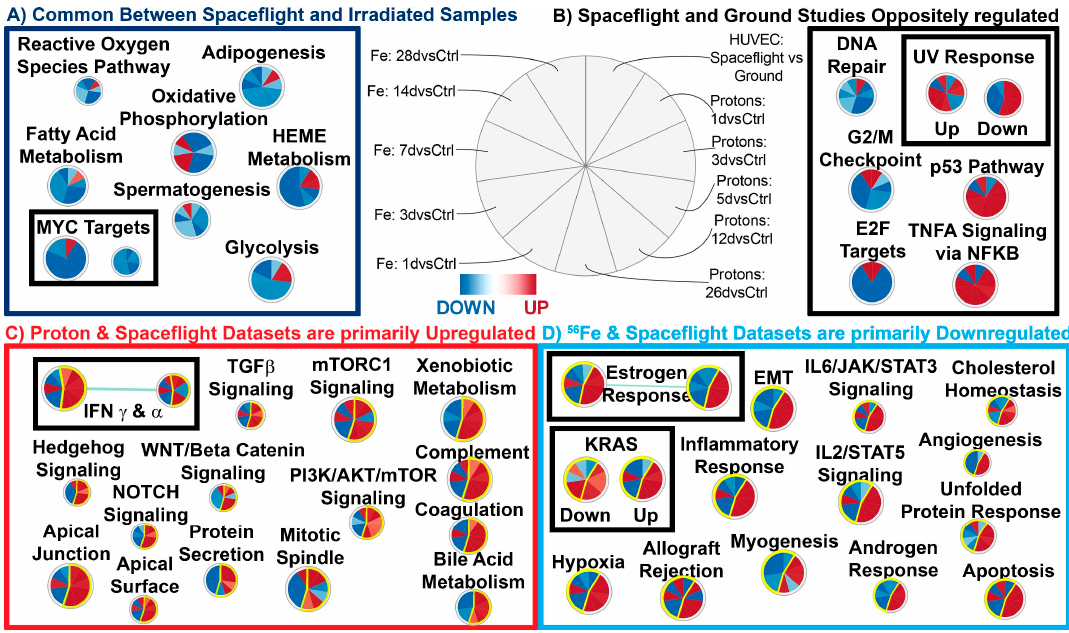
Figure 2. Gene set enrichment analysis (GSEA) emphasizing the hallmark gene sets commonly enriched in cardiomyocytes of irradiated animals or HUVECs flown in space. ( A ) Common Hallmark gene sets enriched in spaceflight samples and irradiated samples. The majority of these datasets are downregulated. ( B ) Hallmark gene sets that are oppositely regulated between all irradiated samples and the spaceflight samples. ( C ) Hallmark gene sets commonly enriched in cardiomyocytes of animals irradiated with 1 GeV/n proton or HUVECs flown in space. Note, most of them are upregulated. ( D ) Hallmark gene sets commonly enriched in cardiomyocytes of animals irradiated with 1 GeV/n 56 Fe or HUVECs flown in space. Note, most of them are downregulated for 56 Fe and spaceflight samples. Note: all samples were comparing experimental conditions with the respective controls. For figures ( C , D ), the common wedges are highlighted in yellow outline. The significant gene sets were determined with false discovery rate (FDR) ≤ 0.05. The legend in the middle of the figure displays what each component/wedge of the nodes represent. Each node contains 11 wedges for each condition and the color of each wedge indicates if the gene set is downregulated (blue) or upregulated (red). The shade of the color indicates the degree of regulation. Each node represents one gene set and the size of the node indicates the number of genes involved with the predictions. Pathways with more than one node are grouped together in the black boxes under each major category.